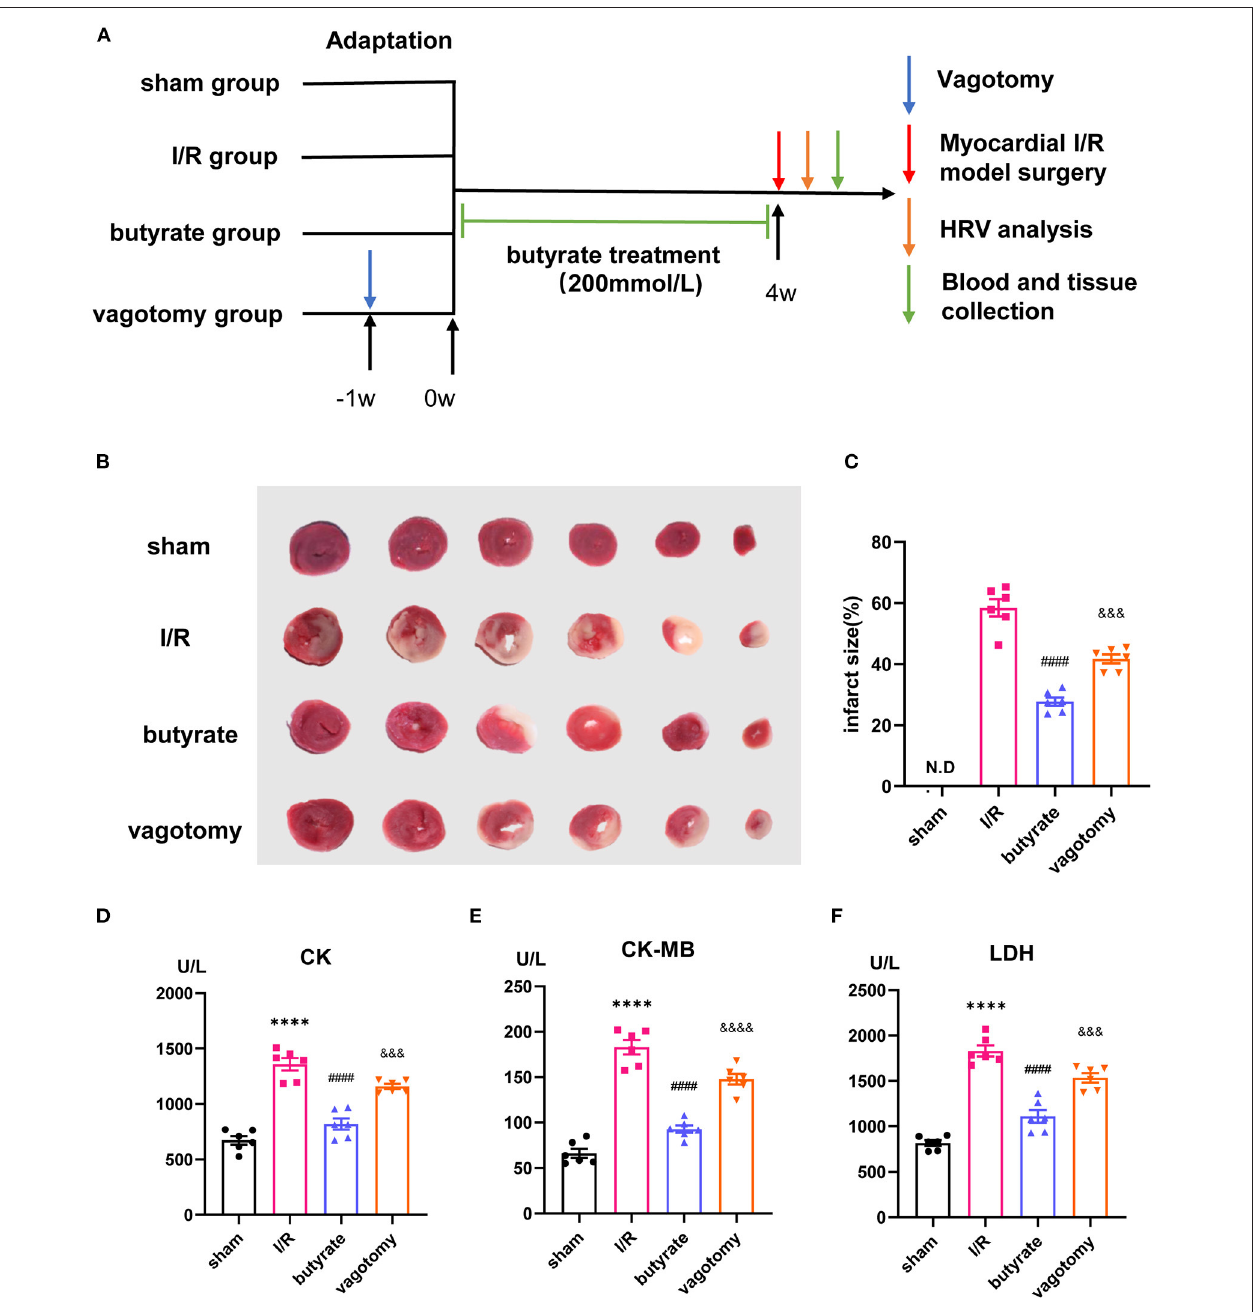
FIGURE 1 | Butyrate treatment attenuated myocardial damage after myocardial I/R, and vagotomy diminished this protective effect. (A) Timeline of vagotomy, myocardial I/R model surgery, and butyrate treatment. (B) Representative images of heart sections by TTC staining. (C) Quantitative analysis of infarct size expressed as percentage of left ventricle, N.D. no detectable. (D) Serum CK, (E) serum CK-MB, and (F) serum LDH levels. **** p < 0.0001 vs. sham group; #### p < 0.0001 vs. I/R group; &&& p < 0.001, &&&& p < 0.0001 vs. butyrate group. I/R, ischemia/reperfusion; HRV, heart rate variability; CK, creatine kinase; CK-MB, creatine kinase-MB; LDH, lactate